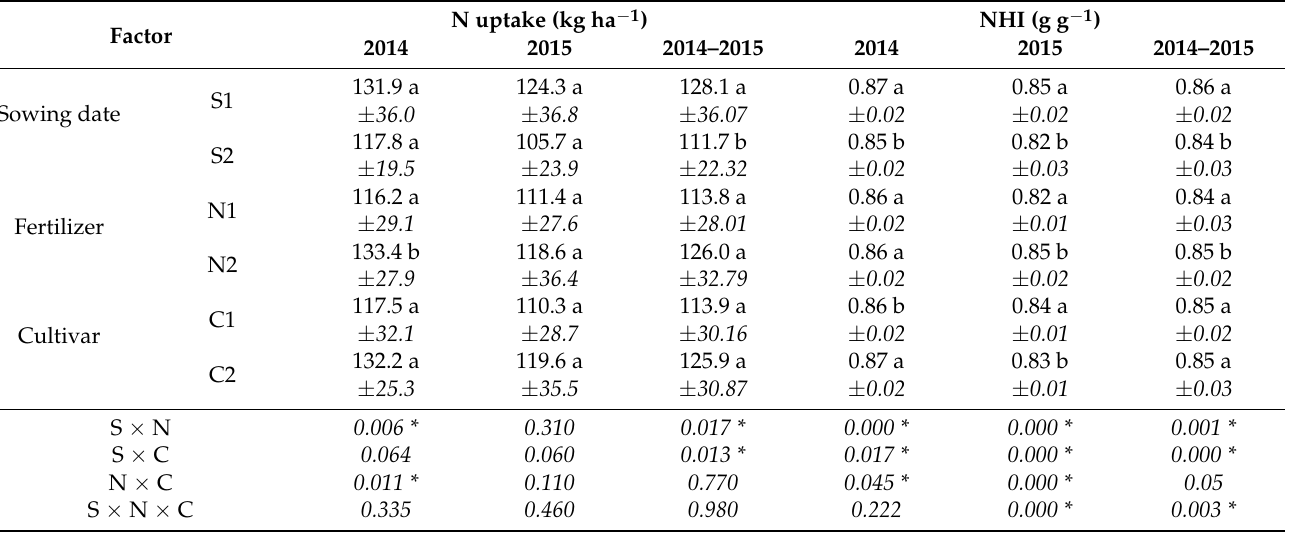
Table 3. N uptake by seeds and nitrogen harvest index (NHI) depending on sowing date, fertilization, and